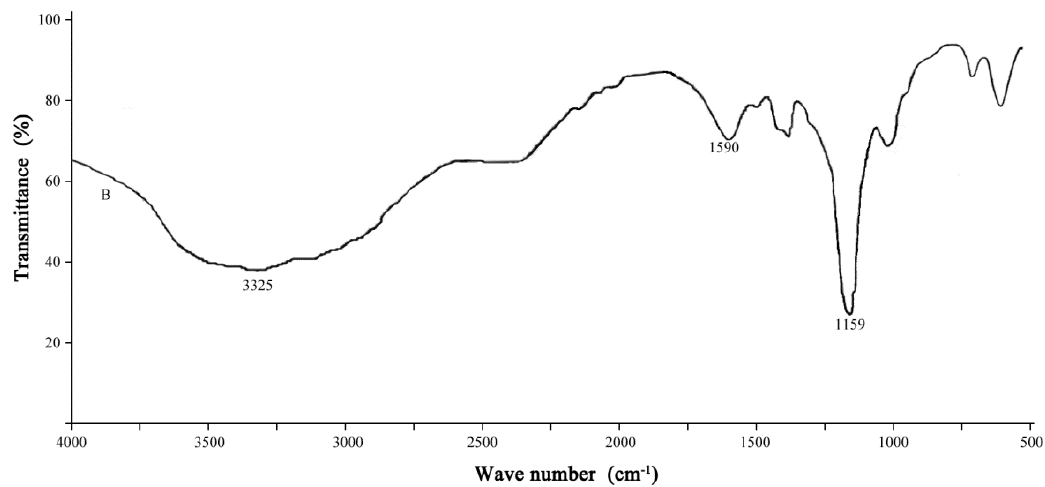
Figure 6. FT-IR analysis of PAM before and after biodegradation. Line A is the spectrum of uninoculated control; line B is the spectrum of PAM after 7 days